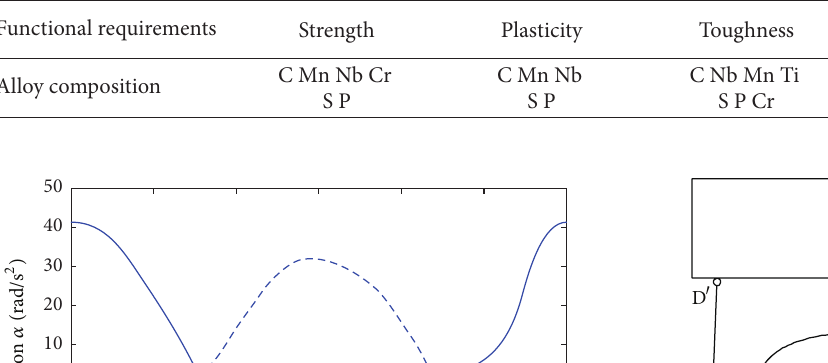
Table 1: The function requirements with alloy composition.